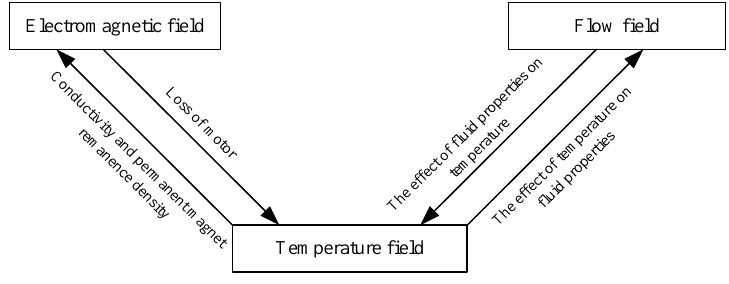
Figure 10. Schematic diagram of strong coupling relationship.